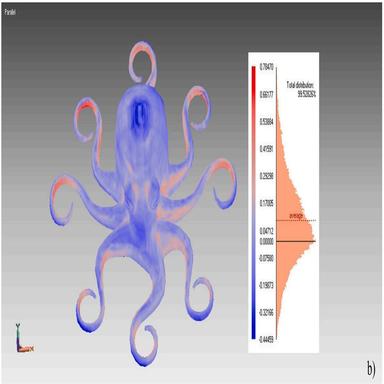
Variance distributions of W14 a) stylized shark and b) octopus.